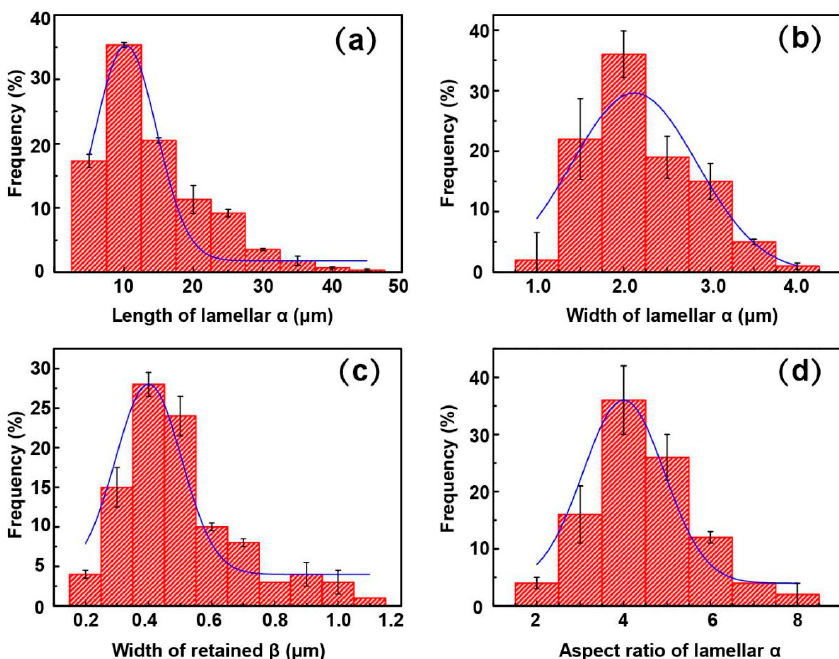
Figure 8. Distribution of microstructural features of TC4F Sample 4 after treatment. ( a ) Length of lamellar α , ( b ) width of lamellar α , ( c ) width of retained β , and ( d ) aspect-ratio distribution of lamellar α . Microstructural features followed Gaussian distribution. Most probable values of α length, width, aspect ratio, and retained β were ~3, ~1.2, ~4, and ~0.20 μ m, respectively.